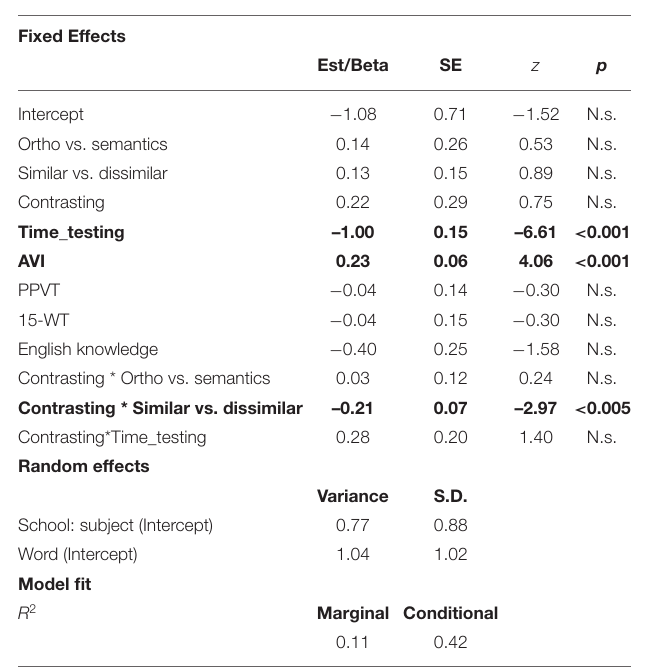
TABLE 2 | Summary of the generalized linear mixed-effects model for the post-tests data, including estimates, standard errors (SE), z values, and significance level.